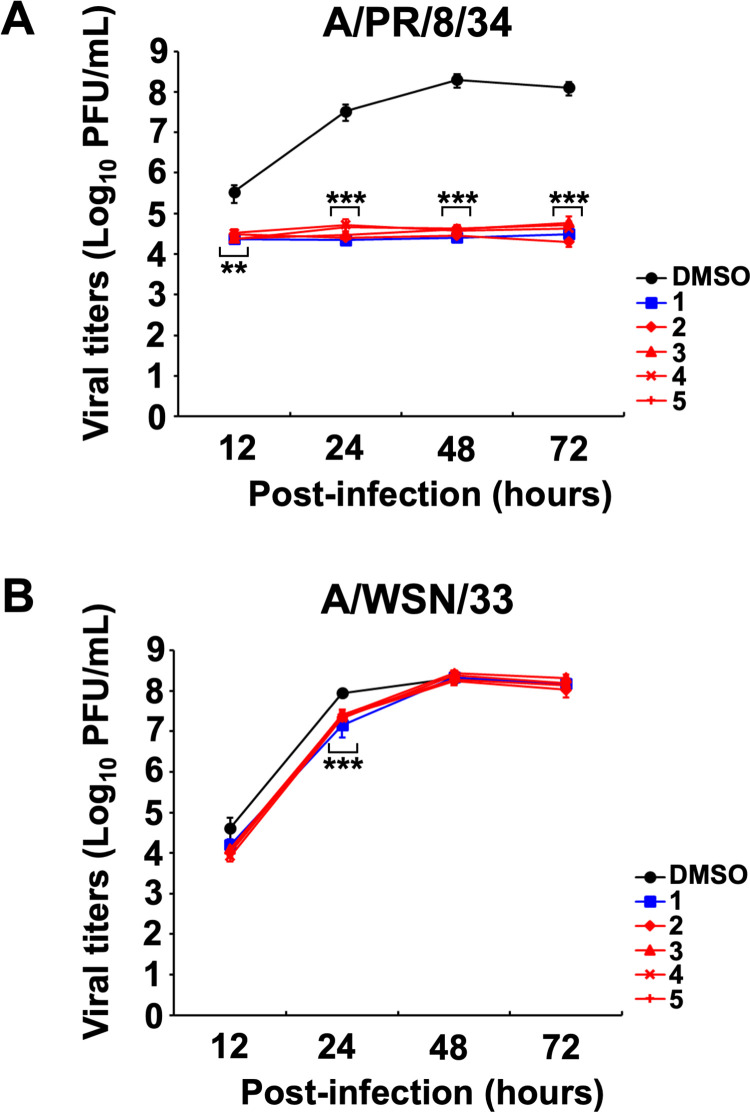
Cyclobakuchiols A–D inhibits influenza A viral growth.MDCK cells were infected with A/PR/8/34 (A) or A/WSN/33 (B) viruses prior to the addition of cyclobakuchiol A (2), B (3), C (4), and D (5) (12.5 μM; n = 9), DMSO (0.125%; n = 9) or (+)-(S)-bakuchiol (1) (12.5 μM; n = 9). The conditioned culture media were collected at the indicated time-points and added to MDCK cells, and the treated cells were immunostained. The viral titers were calculated from the number of stained cells. Data represent the mean ± SEM and are representative of three independent experiments. **p < 0.01, ***p < 0.001 for the comparison of DMSO-treatment. Results were reproducible in this experiment.